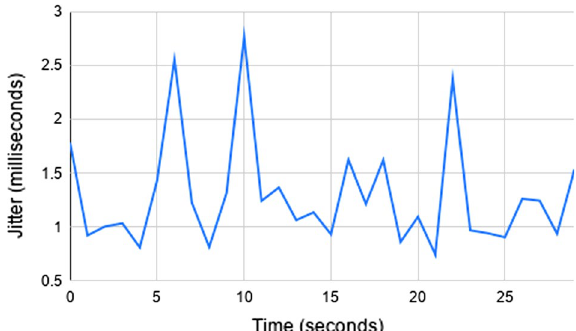
Fig. 7 iperf3 test results for jitter on the testbed for a 30 s window connecting from an edge device to another edge